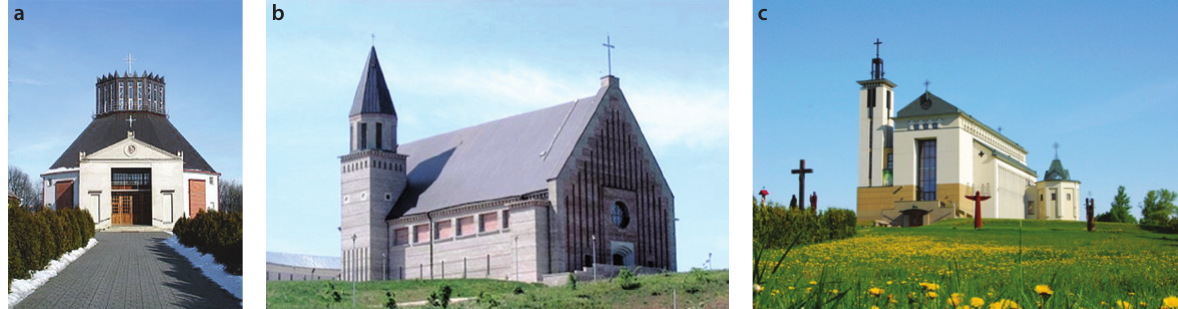
Kankinių bažnyčia (archit.: K. Pempė, A. Asauskas, R. Mulokas ir G. Ramunis, 1993–2002 m.) Fig. 5. Churches of Traditional model: a – Church of St. Kasimir in Kaunas (achit. A. Kančas, 1997), b – Church of Blessed Virgin Mary, Helper of Christians in Alytus (archit.: K. Pempė, K. Kisielius and G. Ramunis, 1991–2000), c – Church of Lithuanian Martyrs in Domeikava (archit.: K. Pempė, A. Asauskas, R. Mulokas and G. Ramunis,